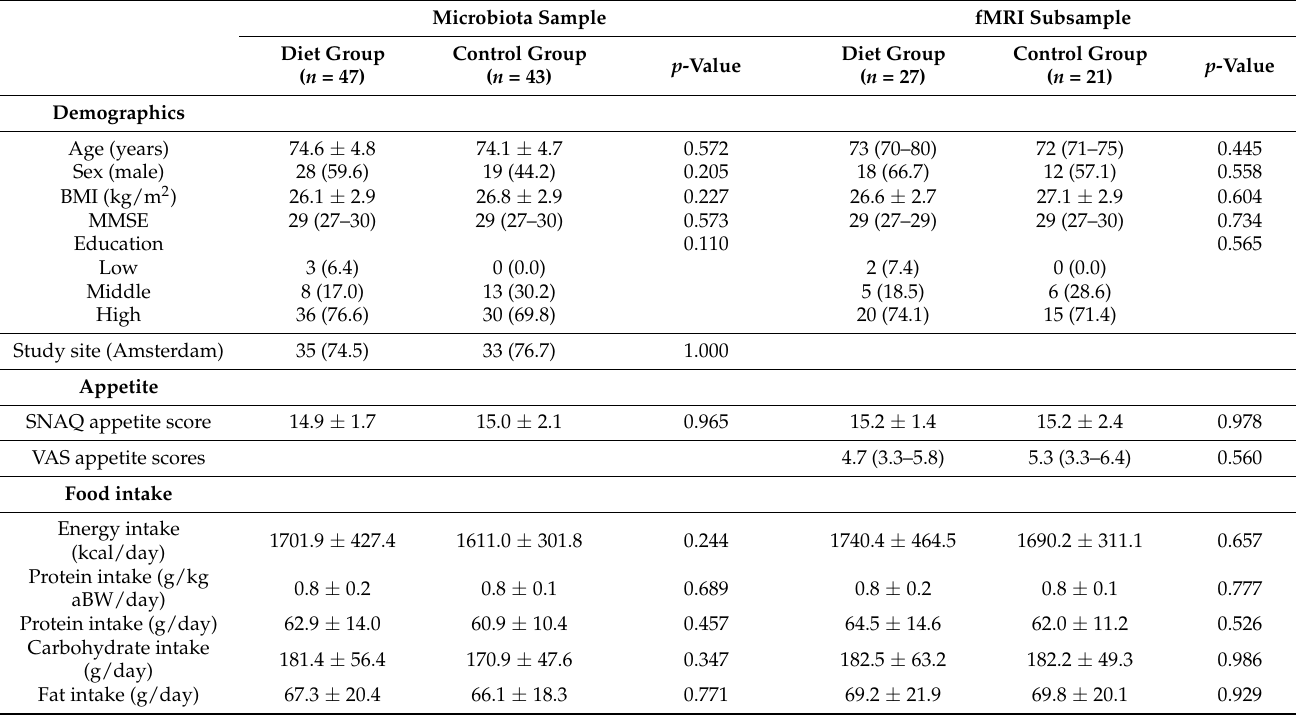
Table 1. Baseline characteristics of microbiota ( n = 90) and fMRI sub-samples ( n =